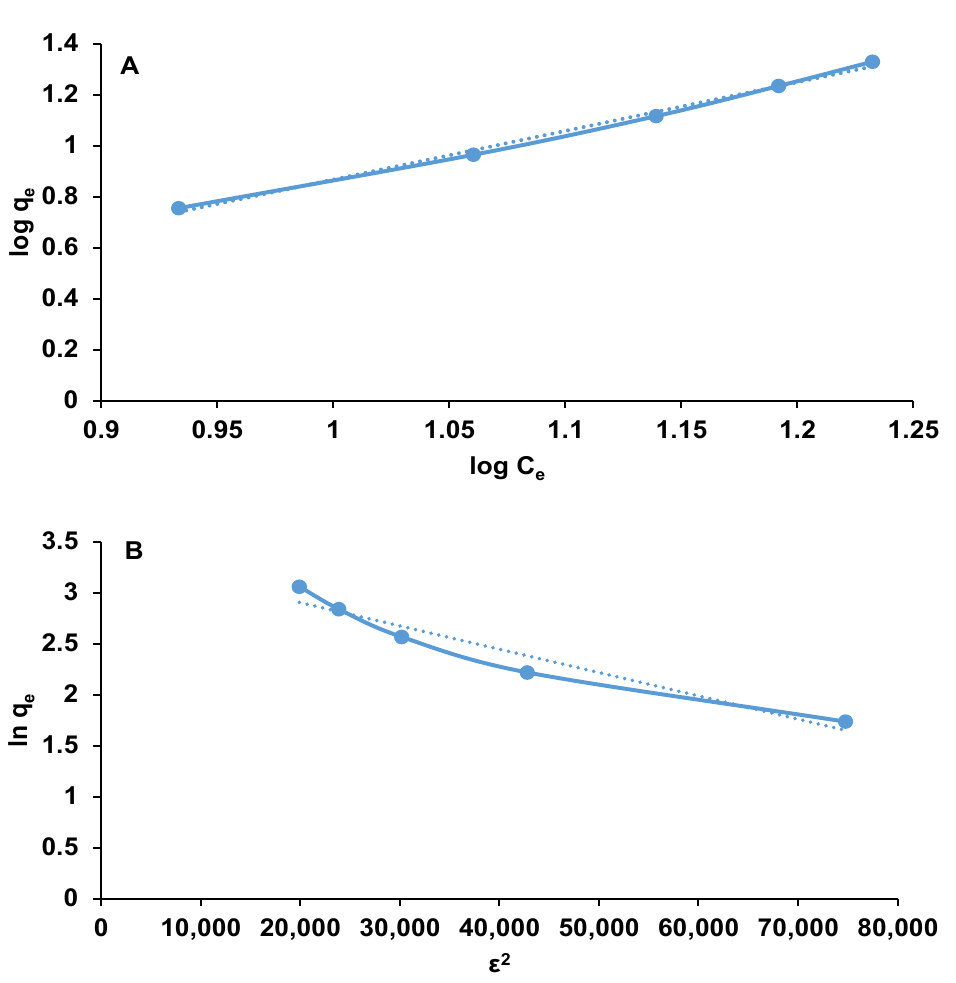
Figure 8. Freundlich ( A ) and Dubinin–Radushkevich ( B ) equilibrium isotherms for the biosorption of EL on the synthesized biosorbent. Table 2. Freundlich and Dubinin–Raduschkevich isotherm models of EL biosorption process on Saccharomyces pastorianus /calcium alginate beads.